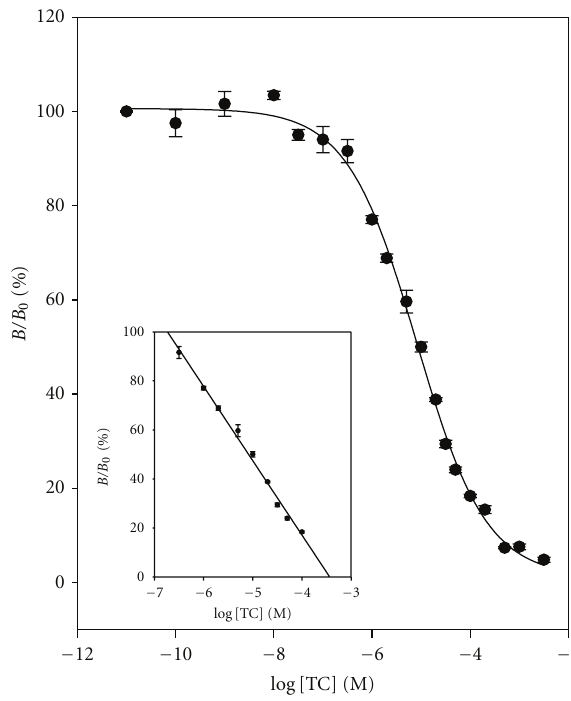
Figure 3: Dose-response curve and calibration curve (inset) for TC in bu ff er. % B/B 0 = − 30 . 3121 × log [TC] − 104 . 0775, R 2 = 0 . 9934. Data points are the average plus ± one standard deviation ( n = 3).